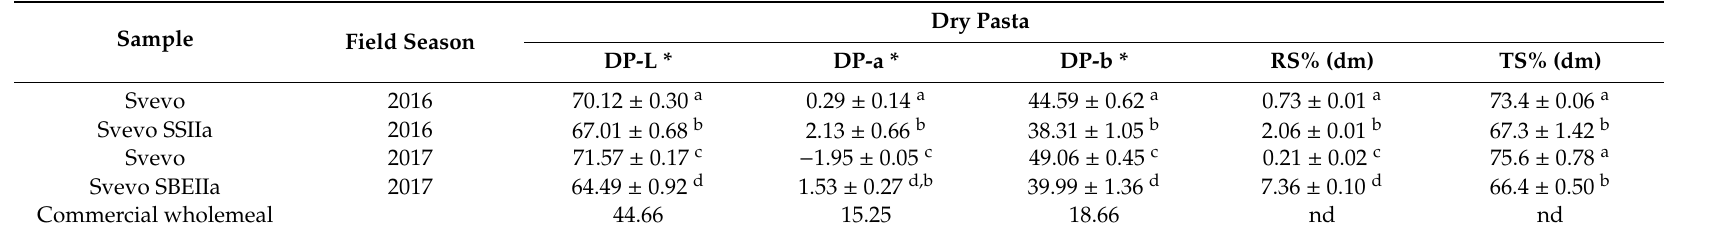
Table 2. Pasta properties of HA and control